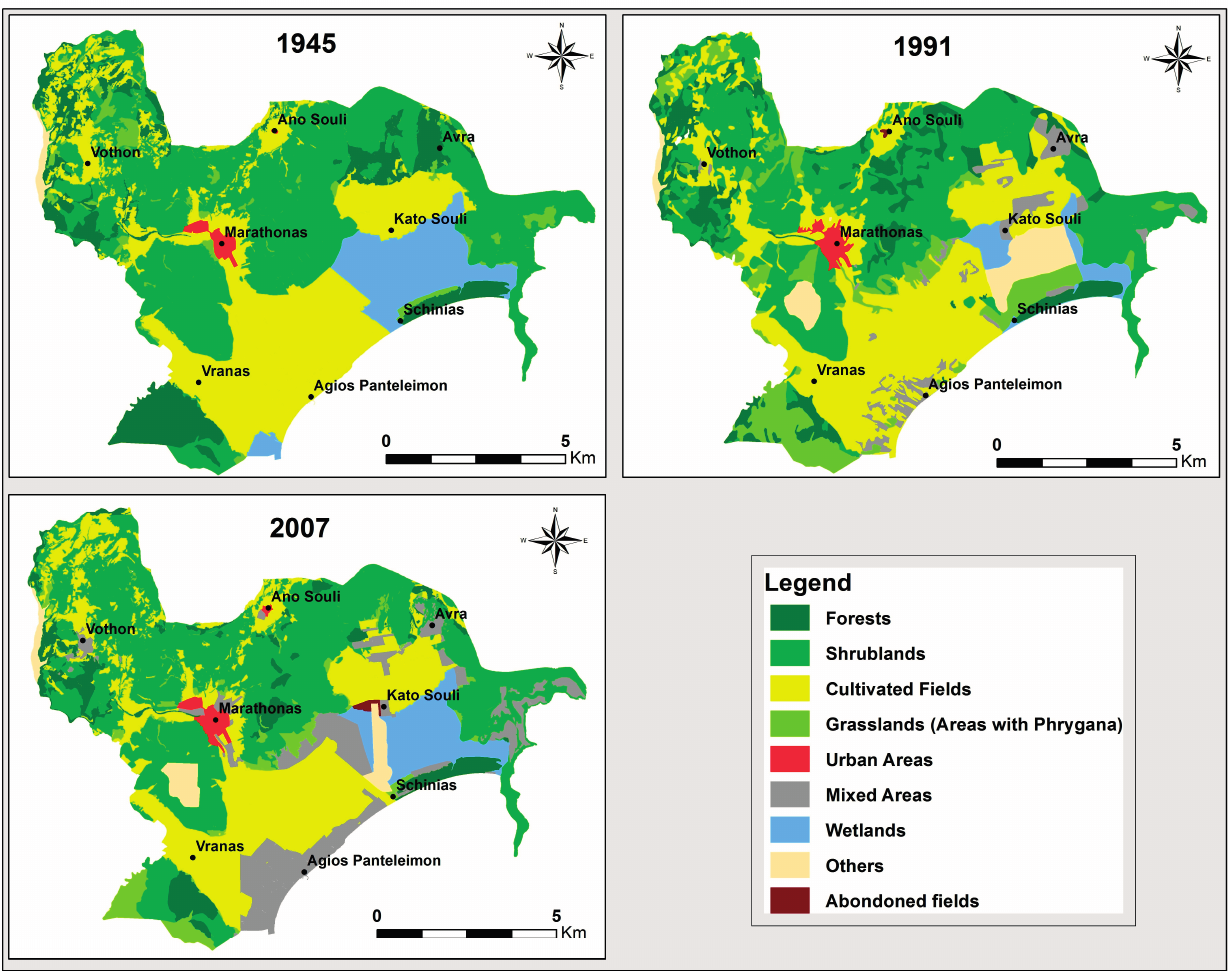
Figure 3. Evolution of land cover (1945, 1991,